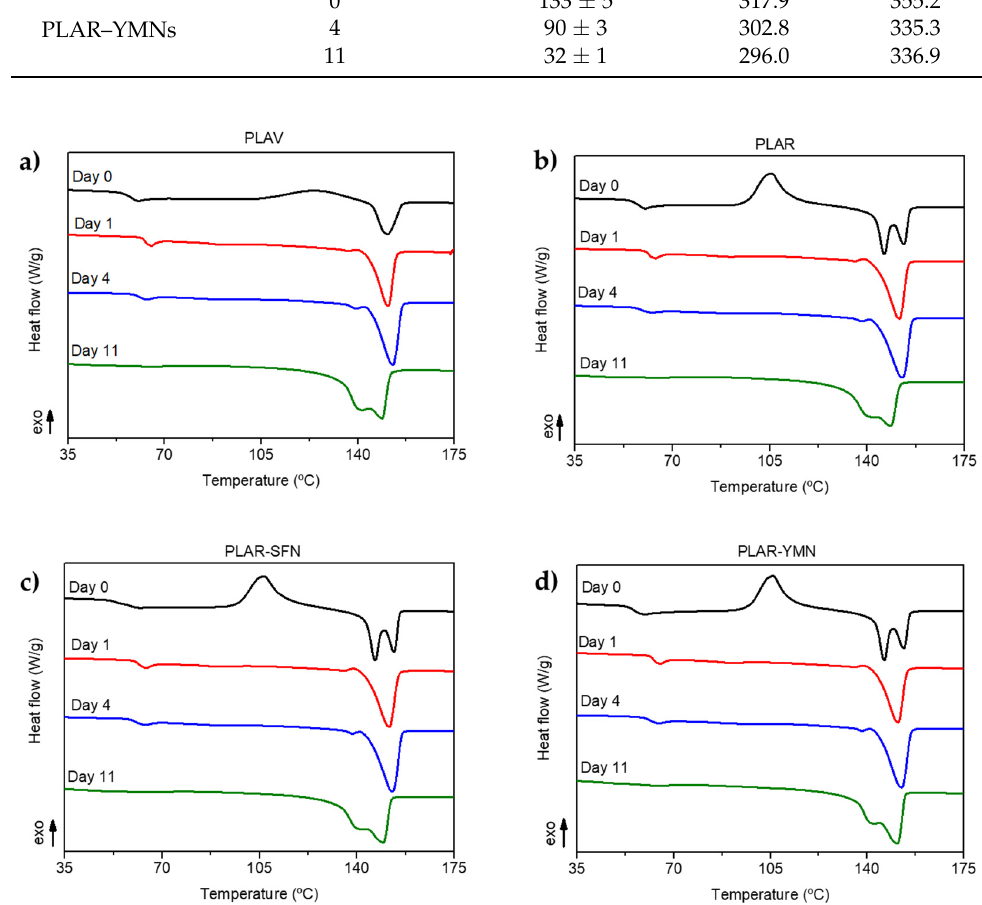
Figure 11. DSC first heating scan of ( a ) virgin PLA (PLAV), ( b ) recycled PLA (PLAR), ( c ) recy- cled PLA-silk fibroin nanoparticles nanocomposite PLAR-SFN, and ( d ) recycled PLA-yerba mate nanoparticles nanocomposite PLAR-YMN before and after different days of